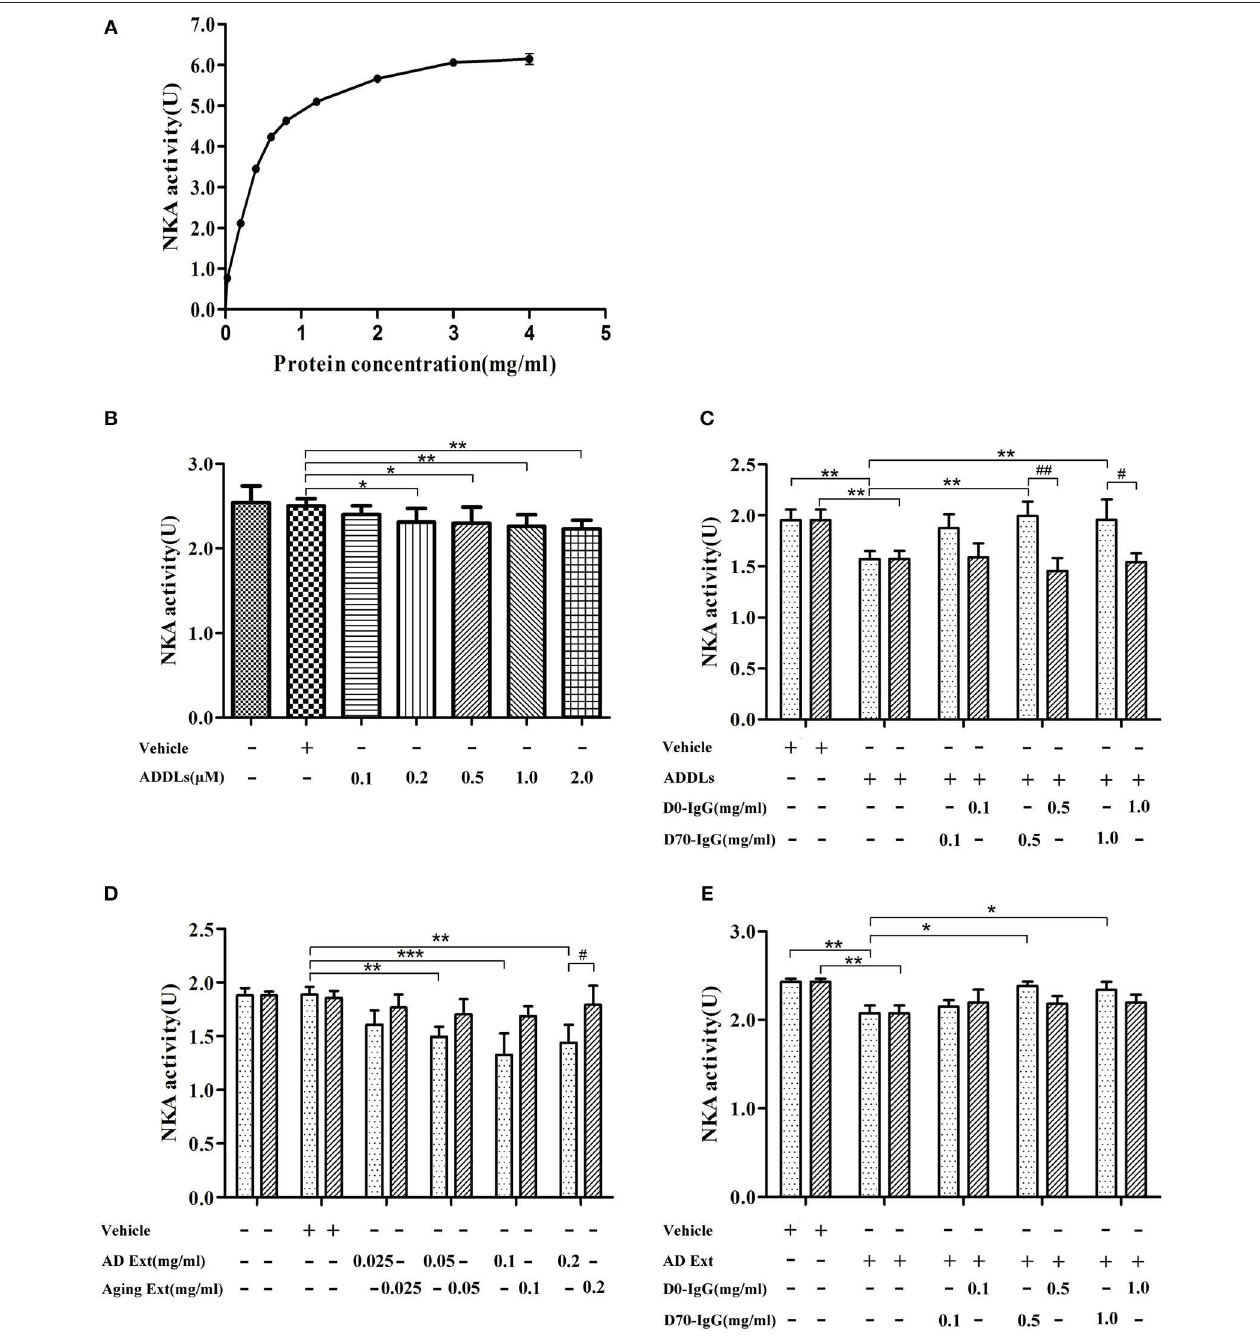
FIGURE 8 | Antibody D70 to A β Os prevented A β Os inhibiting NKA activity of synaptosome in vitro . (A) Determination of NKA activity curve of synaptosome of mice by NKA enzyme Kit. The maximum activity of NKA was 6U, and the protein concentration corresponding to the 1/2Umax was 0.3 mg/ml ( n = 3). (B) Artificial A β Os (ADDLs) inhibited mouse synaptosomal NKA activity (0.3mg synaptosomal protein/ml) ( n = 9). (C) A β O antibody (D70) prevented artificial A β Os (1 µ M) from inhibiting synaptosomal NKA activity ( n = 3). (D) Soluble A β extracts of human AD cerebral cortex inhibited NKA activities in mouse synaptosomes ( n = 3). (E) A β O antibody (D70) prevented soluble A β extracts of human AD cerebral cortex inhibiting synaptosomal NKA activity ( n = 3). Each value is expressed as mean ± SEM. * p < 0.05, ** p < 0.01, *** p < 0.001, # p < 0.05, ## p < 0.01. that oligomers of A β can inhibit all these kinds of Na/K- can selectively inhibit α 3-Na/K-ATPase activity. Mice cortical ATPase activity, and did not show selectively inhibit α 3-Na/K- synaptosome, heart cell membrane and kidney cell membrane ATPase activity, which suggests that oligomers of A β may were used to test bioactivity of oligomers of A β . Results showed